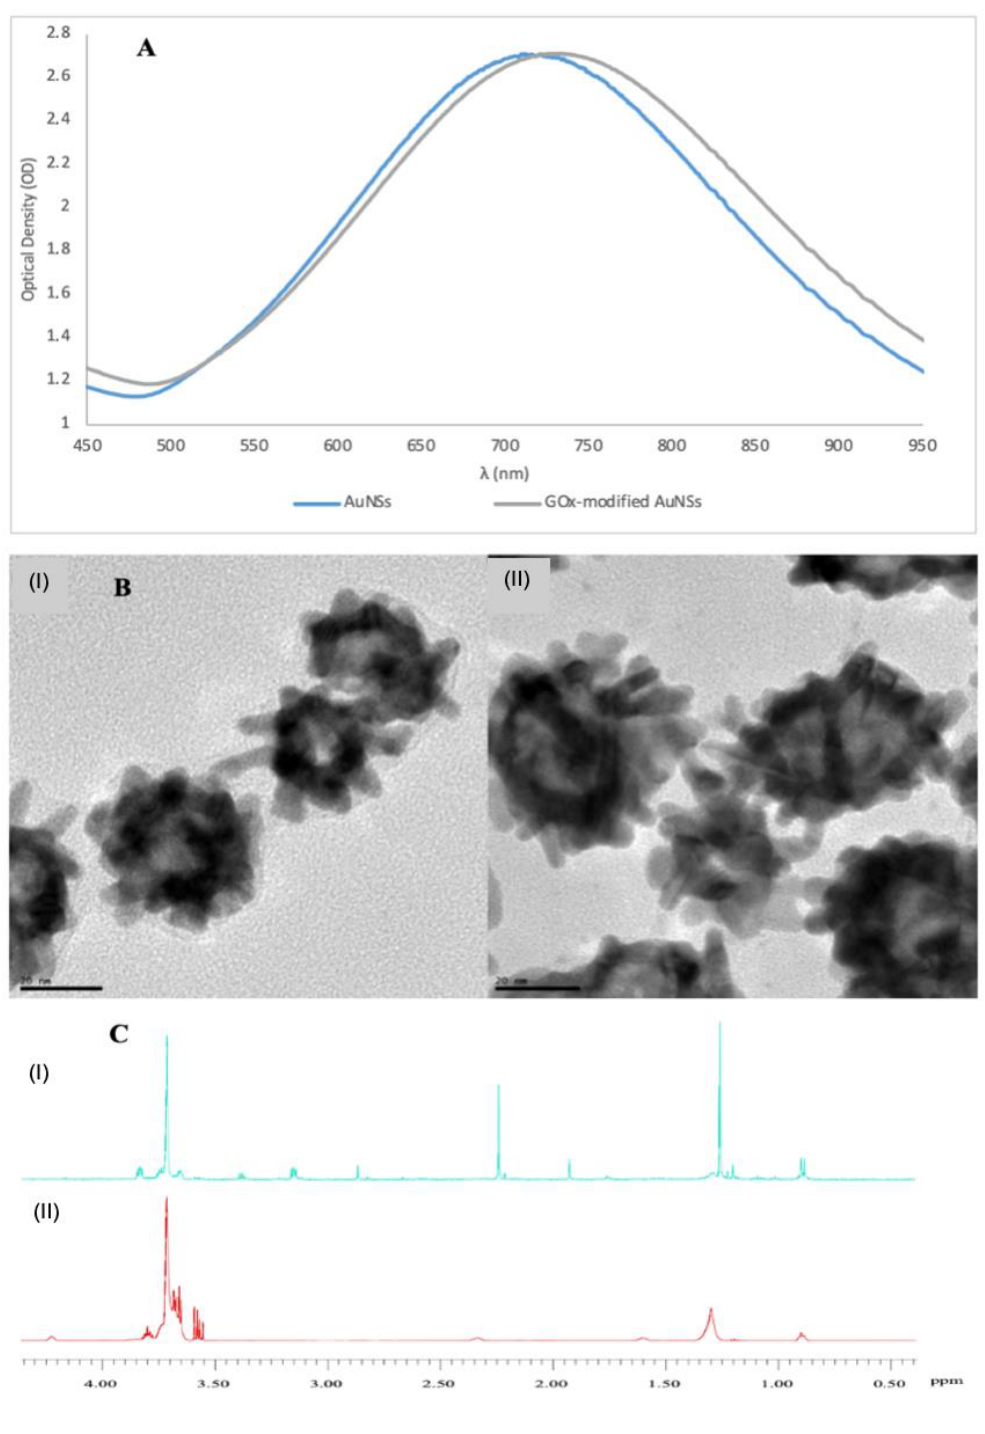
Figure 1. ( A ) Normalised UV-vis spectra showing a red-shift for the AuNSs modified with 0.042 mmol / L of glucose oxidase (GOx). ( B ) High resolution transmission electron microscope (HR-TEM) images of (I) polyvinylpyrrolidone (PVP)-stabilised AuNSs, and (II) GOx-modified AuNSs. ( C ) 1 H-NMR spectra of (I) cysteine-modified AuNSs, and GOx-modified AuNSs using cysteine and N -(3-Dimethylaminopropyl)- N (cid:48) -ethylcarbodiimide hydrochloride (EDC) / sulfo-NHS for bioconjugation. (The images were adapted and used with permission from Phiri et al.